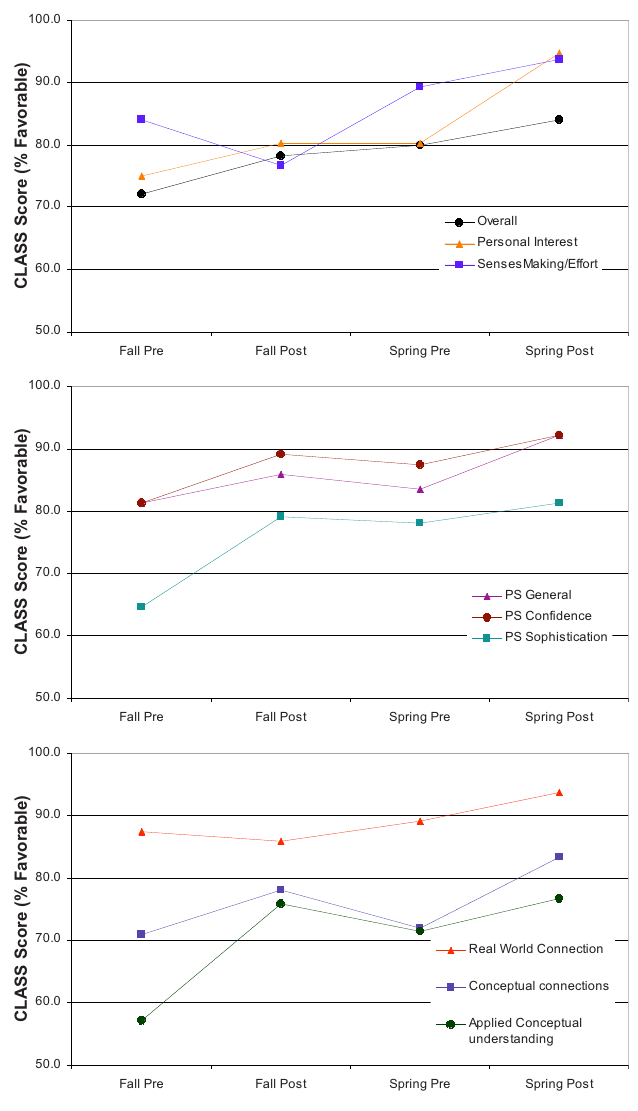
FIG. 3. (cid:1) Color online (cid:2) Average CLASS Scores Fall Pre, Fall Post, Spring Pre, Spring Post for all course completers (cid:1) N =16 (cid:2) (cid:1) p (cid:1) 0.05, (cid:1)(cid:1) p (cid:1) 0.01. The standard errors on these data points are similar to those reported in Figs. 1 and